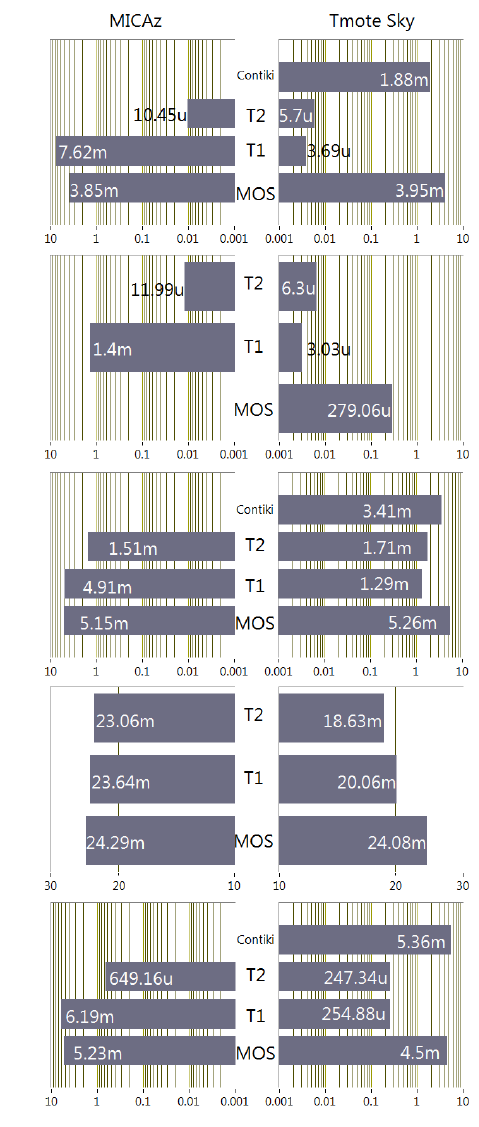
Figure 2. Average current consumption. First row blank program; second row Blank2 program with optimized consumption; third row Blink ; fourth Sens sensing and transmission; fifth row Sens2 optimized sensing and